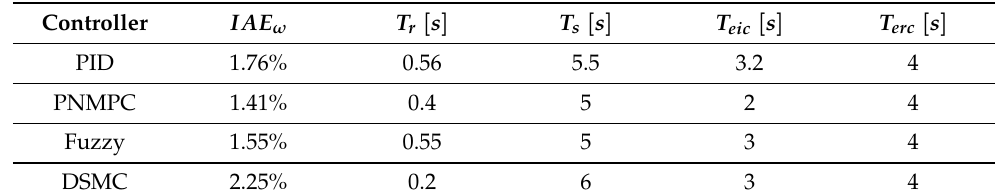
Table 9. System response with load application.